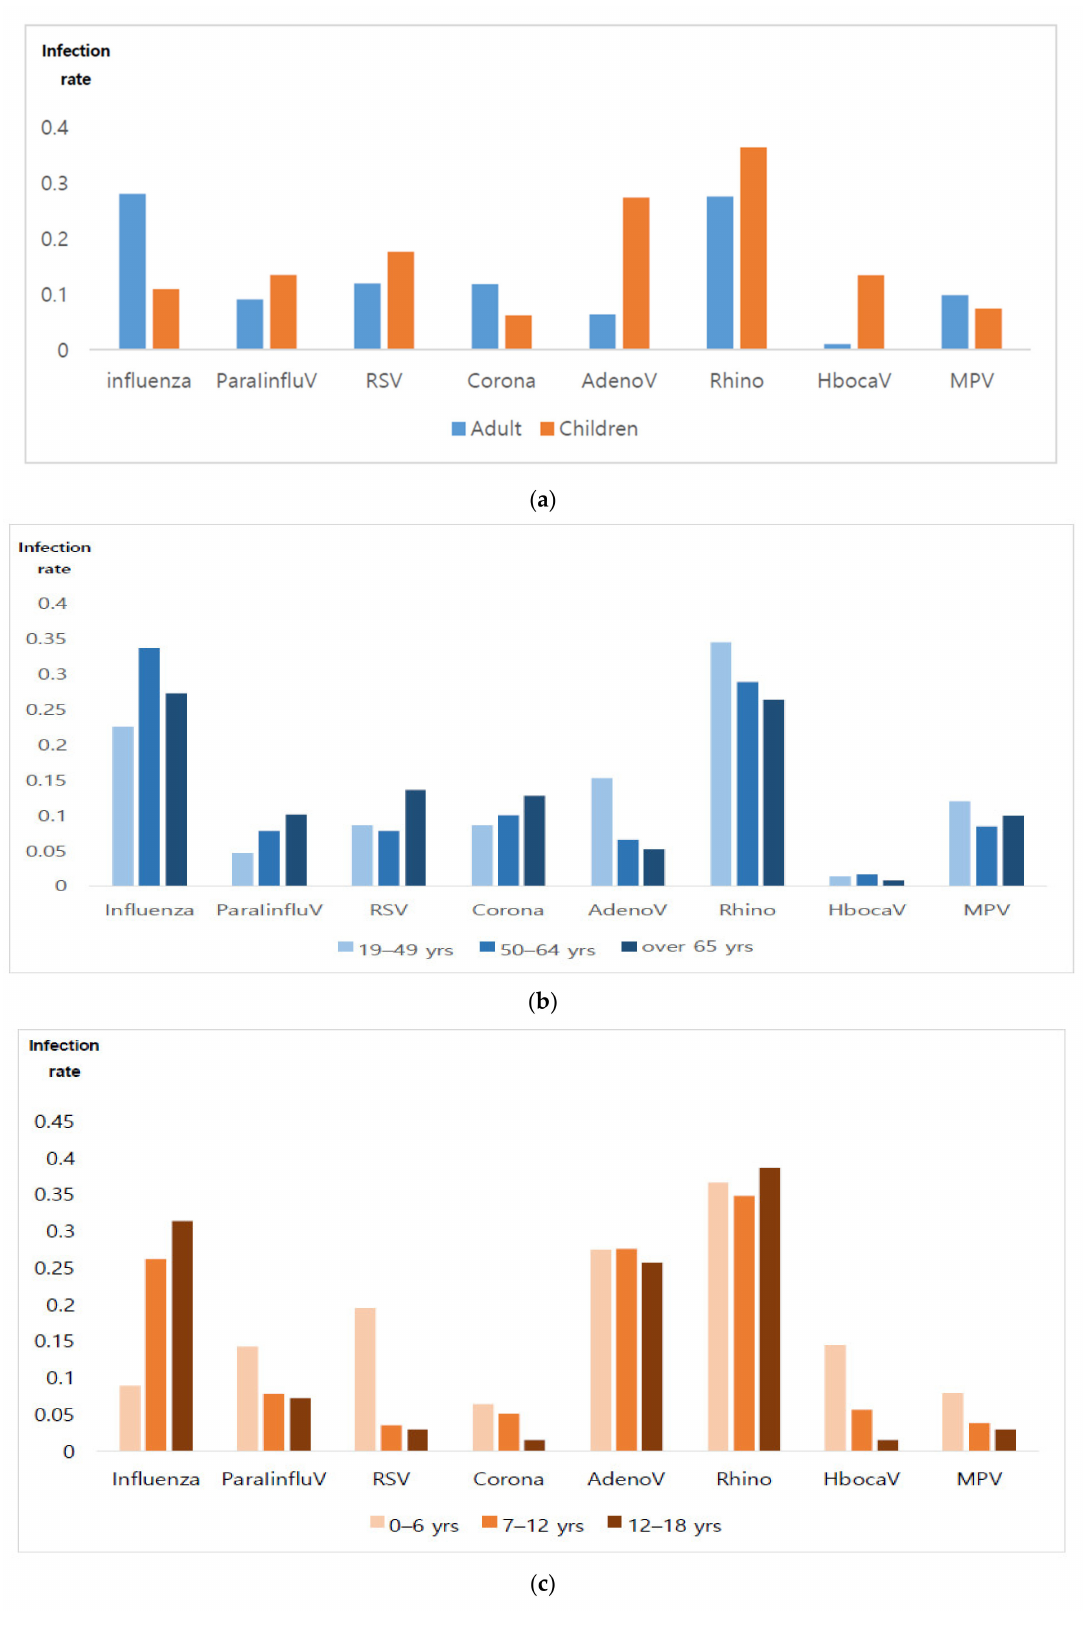
Figure 2. ( a ) Distribution of different types of viral infection rate detected in adult and pediatric patients. (1) The rhinovirus infection rate was highest in children. (2) The influenza infection rate